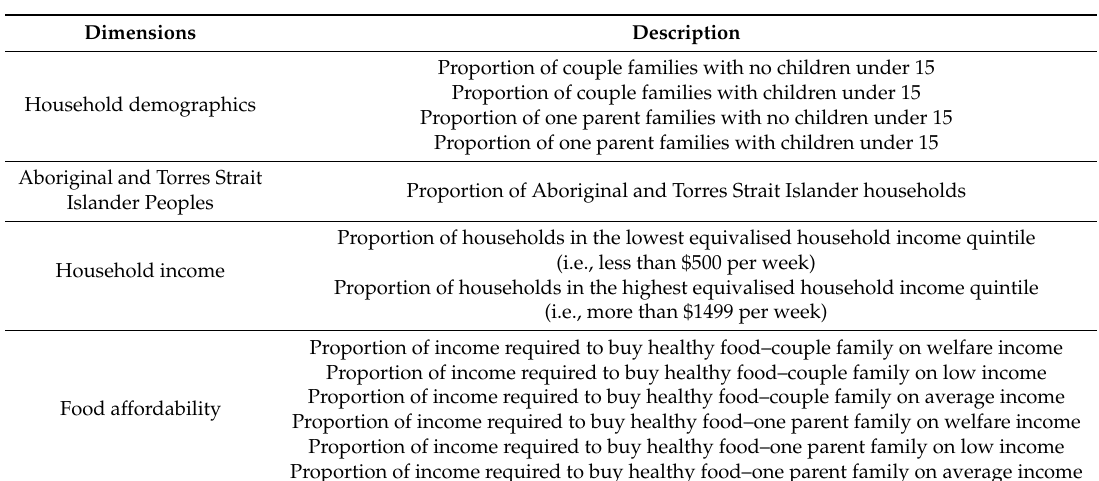
Table 2. Reduced set of variables used to construct the Food Stress